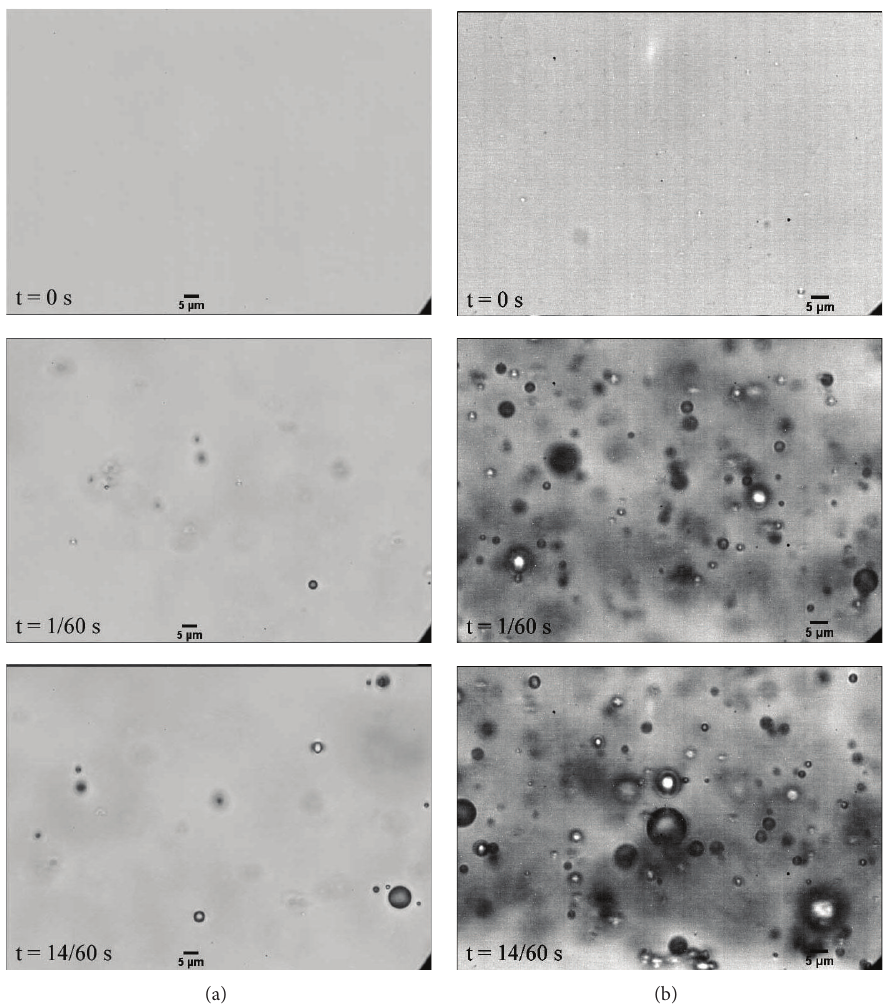
Figure 4: Droplet vaporization revealed microbubble sizes occurring predominantly in the 1–3 𝜇 m range, with an increasing number of bubbles produced as lipid concentration increased. Vaporization was induced with a 10-cycle pulse at 5 MHz. (a) 0.75 mg/mL phospholipid concentration and (b) 3.0 mg/mL phospholipid concentration. Reprinted with permission from [76]. Copyright 2011 American Chemical